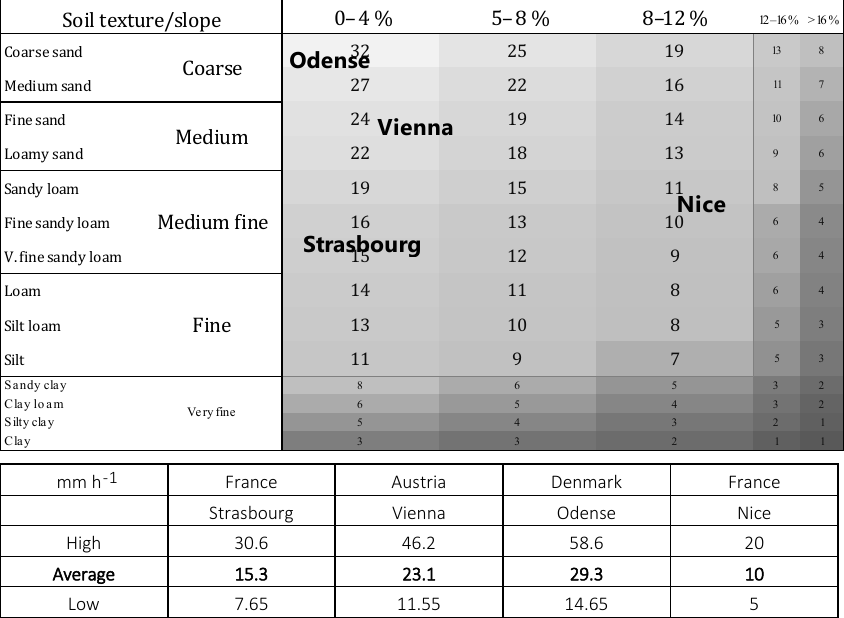
runoff at any stage during the events. The average run-off ra- tio over the entire precipitation event, R r , can therefore be calculated using Eq. 8, i.e. the share of precipitation which does not infiltrate or is transported via the sewer system. The ratio is calculated prior to the horizontal movements of water and driven by the characteristics of the DEM in the MIKE 21 overland flow model (see Sect. 2.5 for information on the flood